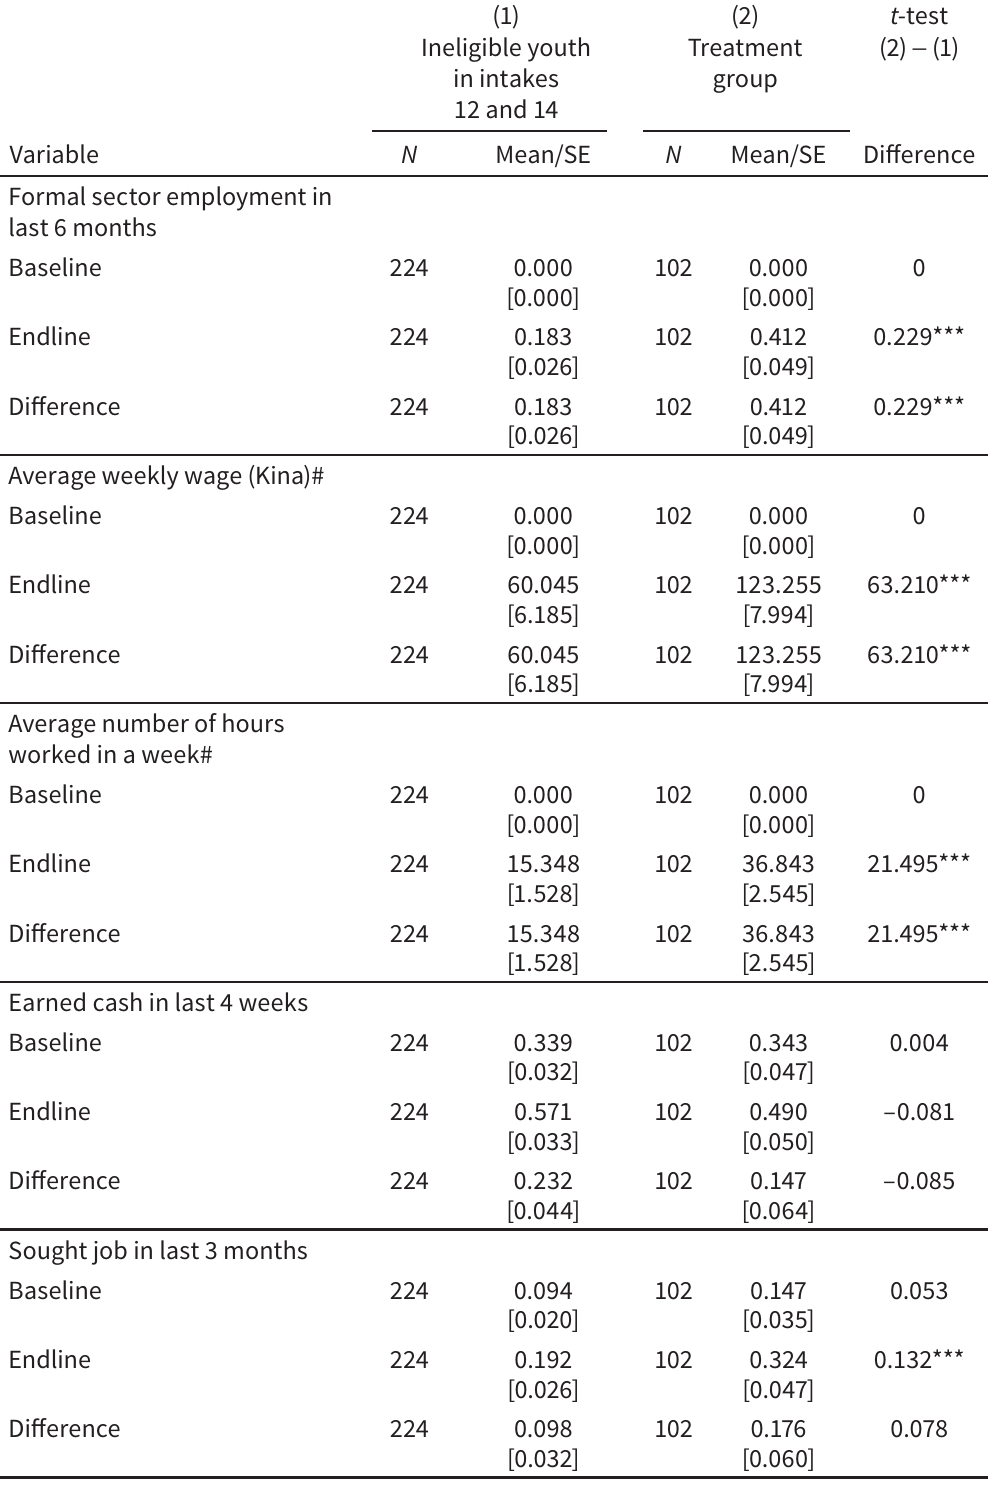
Table A6 Differences in outcomes between youth in the treatment group and youth who were ineligible in intakes 12 and